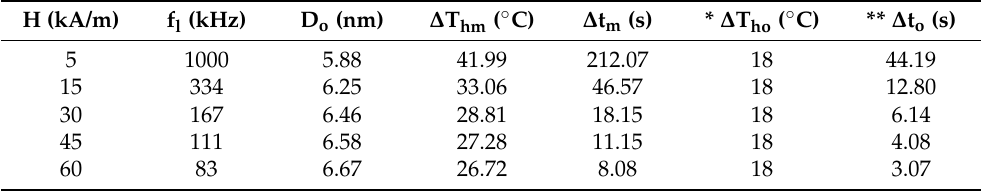
Table 5. The values of the optimal heating times ( ∆ t o ) of the CoFe 2 O 4 nanoparticles under the optimal parameters given in Table 3, for the volume fraction of 0.017. The table also shows the values of the maximum variation of the heating temperature ( ∆ T hm ) of the nanoparticles and their corresponding durations ( ∆ t m ) under the given